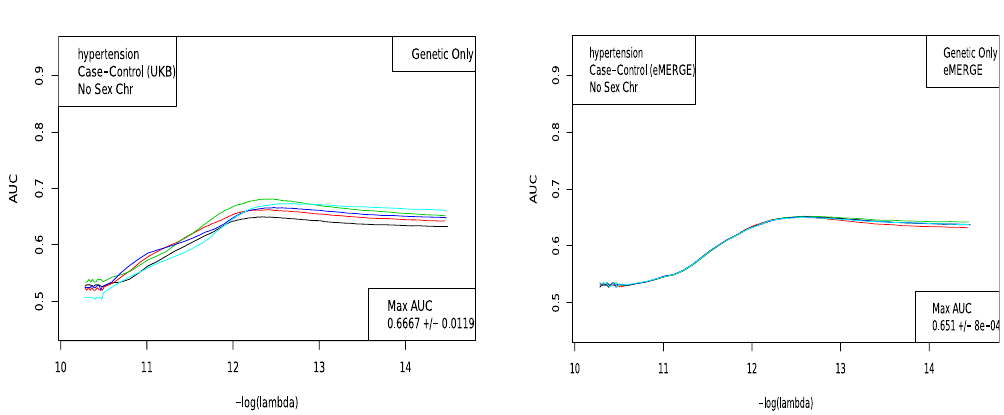
Figure 3. The receiver operator characteristic curve for case-control data on Hypothyroidism. This example includes sex and age as covariates.